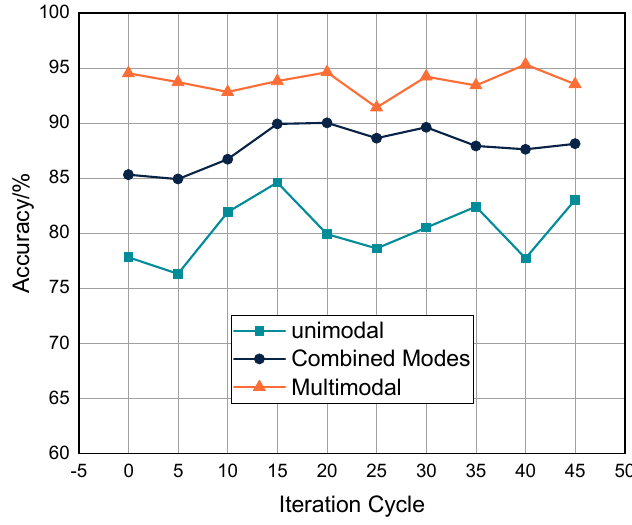
Figure 12. Dependencies of different modal combinations.